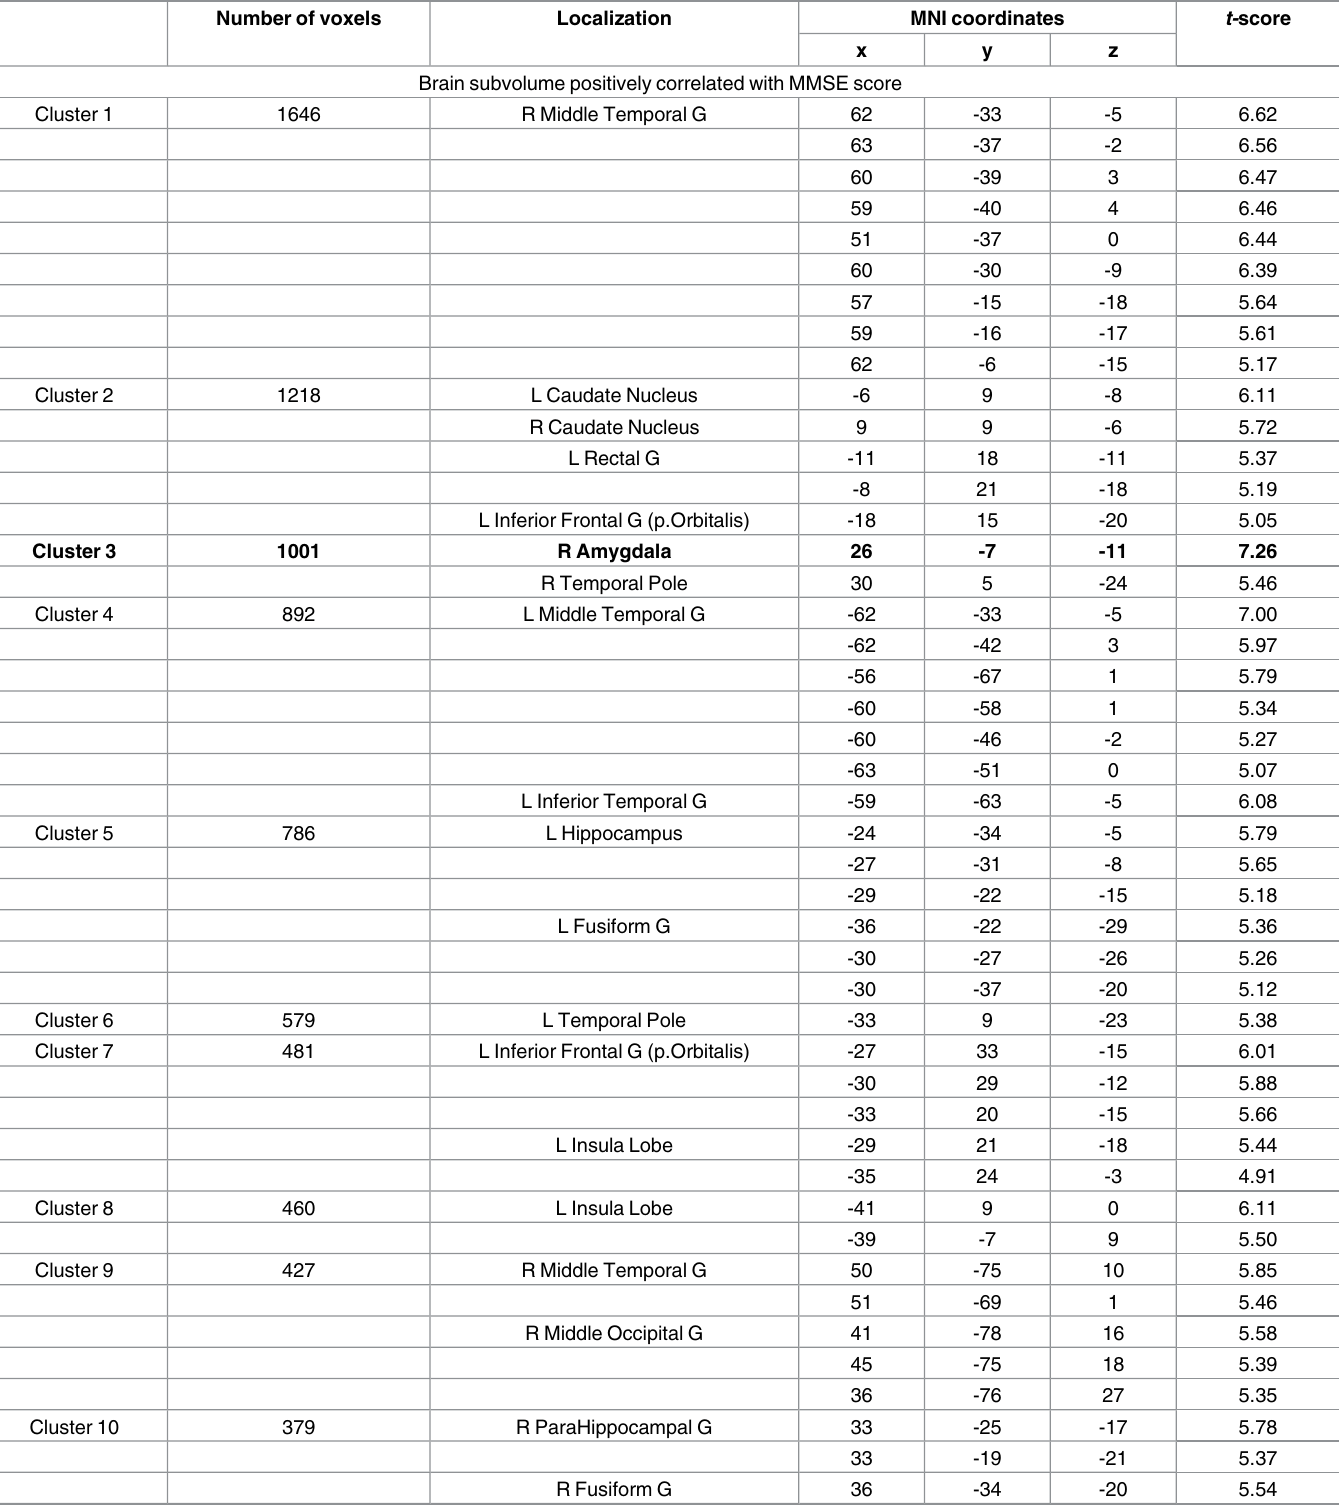
Table 1. Detailed results of the VBM analysis: correlation of gray matter volume with MMSE score and SMMSE score. Number of voxels